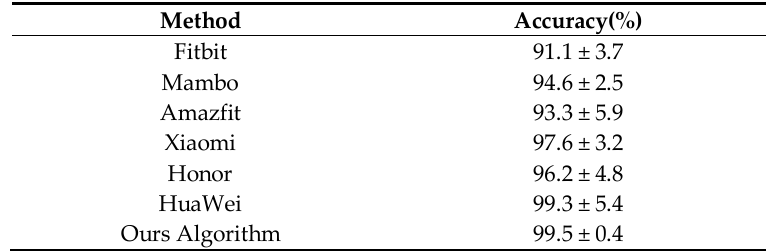
Table 2. The accuracy of our result compare to different bands of sport